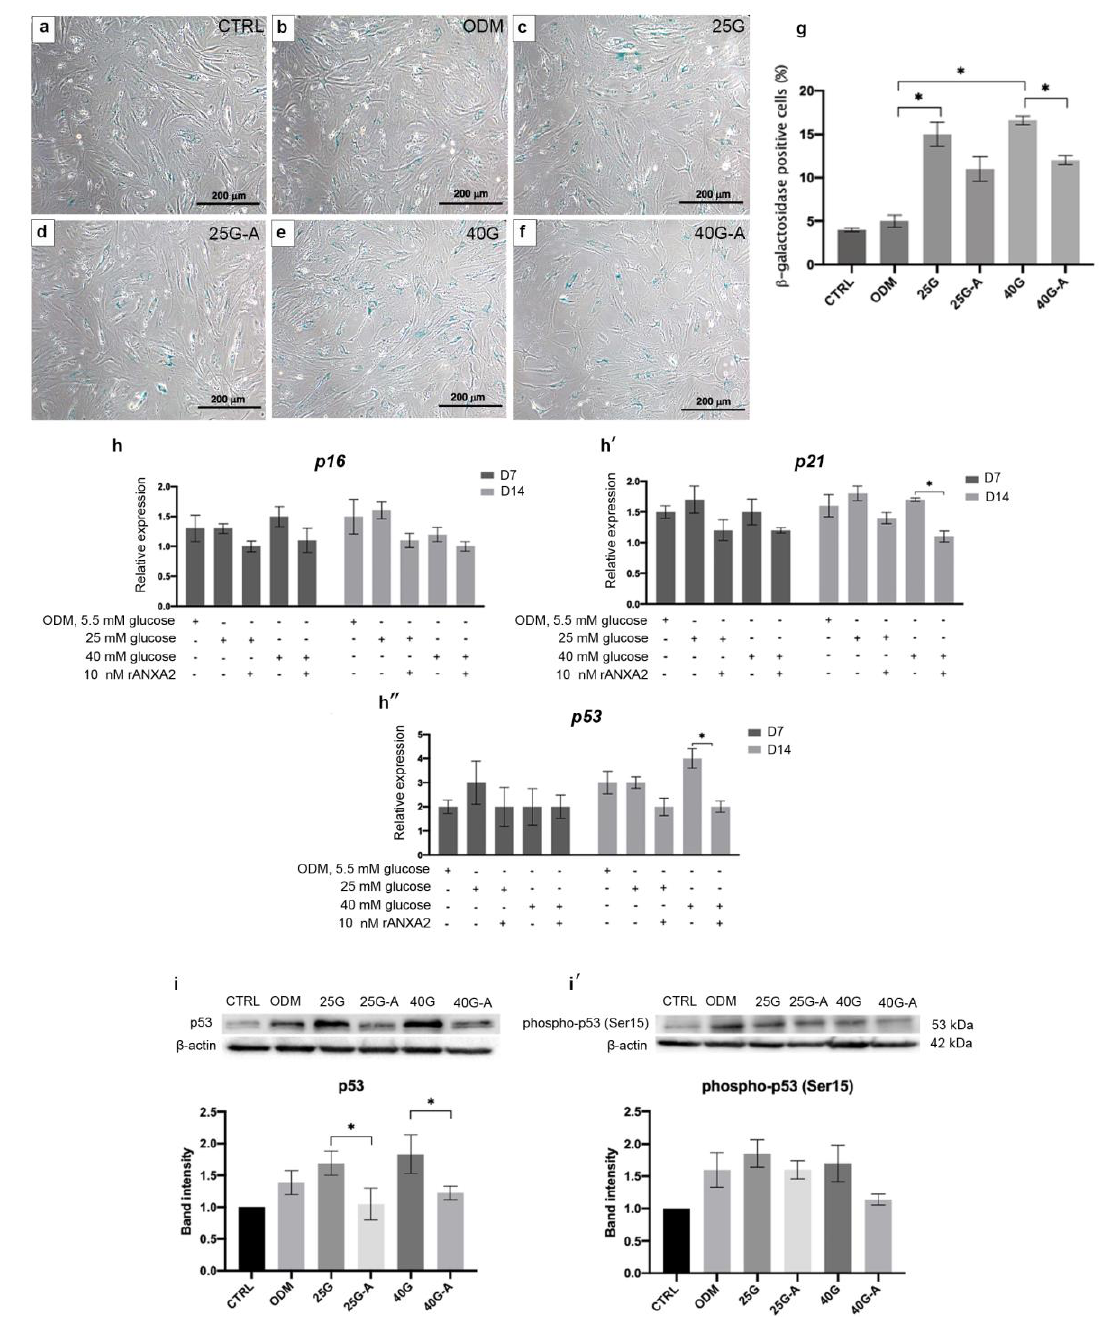
Figure 5. The impact of annexin A2 on cellular senescence of MSCs cultured in ODM with high levels of glucose. MSCs were cultured in ODM under normal (5.5 mM glucose) and high-glucose condition with/without rANXA2 (25G vs. 25G-A, 40G vs. 40G-A). Micrograph show the SA- β -gal positive cells which stained blue in each conditions ( a – f ). Total cells and SA- β -gal positive cells were counted and calculated ( g ). The transcriptional levels of p16, p21, and p53 were determined at day 7 and 14 ( h – h (cid:48)(cid:48) ). Gene expression is presented as relative to CTRL. Western blot analysis of p53 ( i ) and phosphorylated p53 ( i (cid:48) ) was determined at day 14. Protein band intensity is present as relative to CTRL. All data are presented as the means ± SEM from three independent experiments. * p value < 0.05 is considered statistically